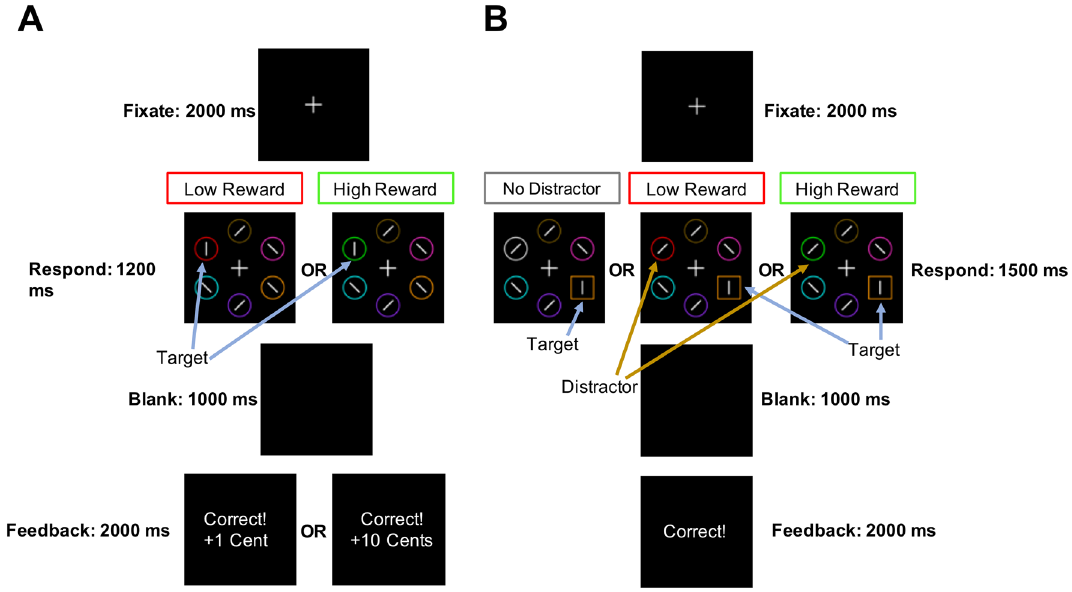
Figure 1. Trial sequence for the two phases of the task. ( A ) Reward association phase: Targets in the reward association phase were defined by a pre-specified color (e.g., red and green). Subjects reported the horizontal or vertical orientation of the white bar inside the target by pressing one of two keys. Correct answers were differentially rewarded based on the color (e.g., 10 cents for green and 1 cent for red). ( B ) Attention test phase: Here subjects were told to ignore the colors. Targets were identified as the unique shape. Once again, subjects reported the orientation of a white bar inside the target by pressing one of two keys. Half of the trials contained a distractor, i.e. a non-target shape in a color previously associated with a reward (e.g., green for the low reward distractor and red for the high reward distractor). The other half of the trials did not include a